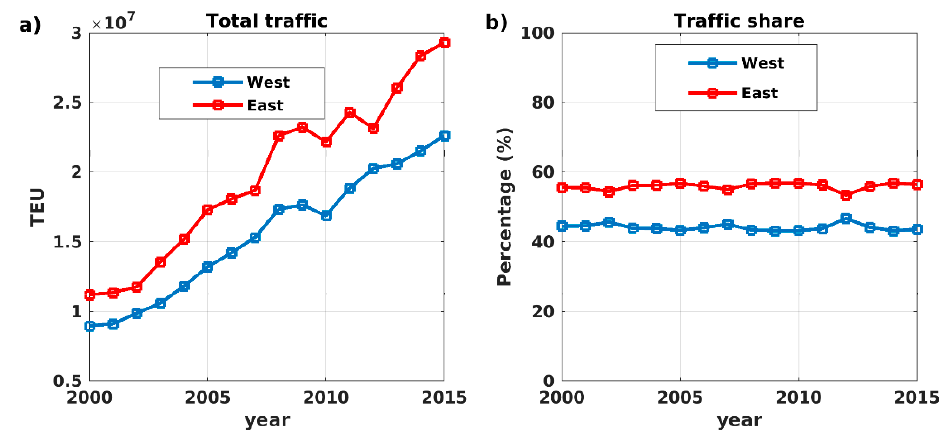
Figure 3. Traffic data description for container ports in the Mediterranean, 2000–2015, according to the two regions defined in Table 1. ( a ) Total container throughput. ( b ) Traffic share.